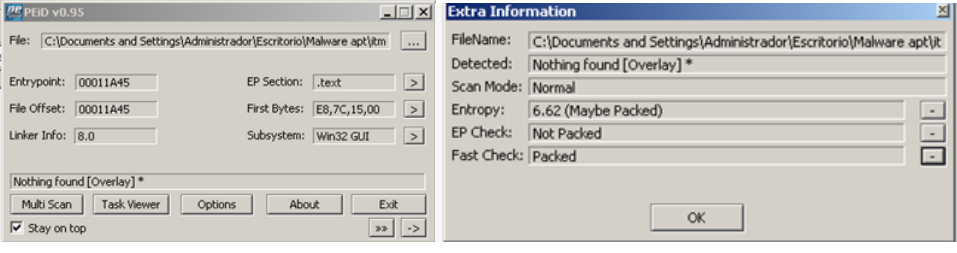
Figure 11. PEiD tool results.